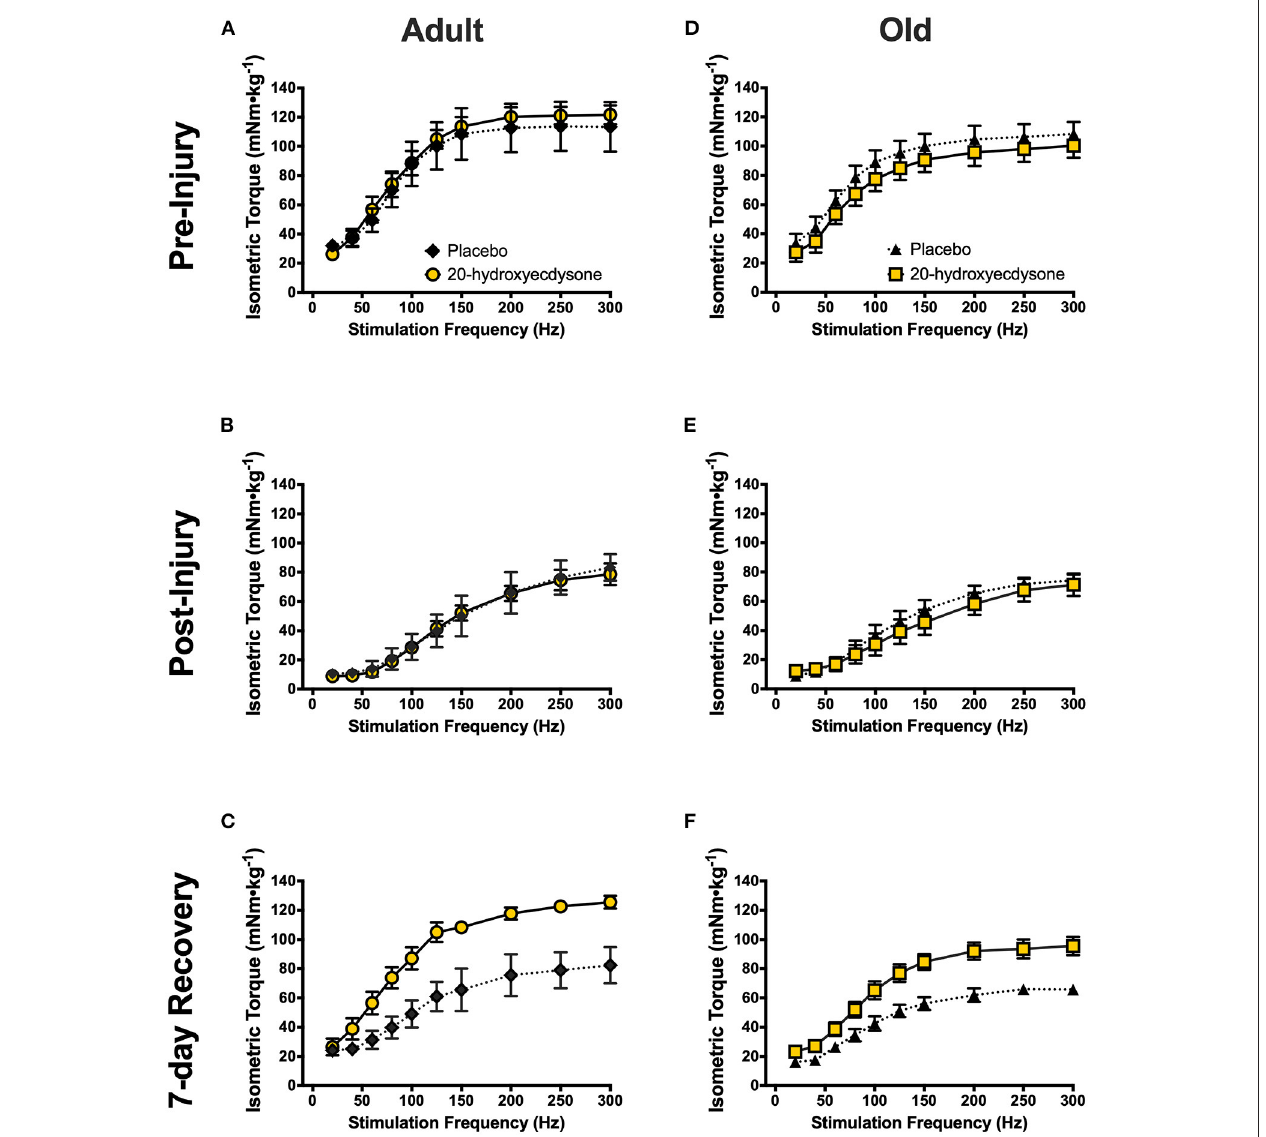
FIGURE 2 | Isometric torque-frequency relationships of the anterior crural muscles in adult and old mice at the pre-injury ( A,D , respectively), immediately post-injury ( B,E , respectively), and 7-day recovery ( C,F , respectively) time points. Analysis revealed significant reductions in isometric torque-frequency relationships in both adult (B) and old mice (E) immediately after the eccentric contraction-induced muscle damage protocol (Post-Injury), compared to Pre-Injury ( A,D , respectively; p < 0.001), regardless of treatment condition. Torque-frequency relationships fully recovered to Pre-Injury levels by the 7-day Recovery time point in both 20E-treated adult (C) and old mice (F) , but PLA-treated mice did not recover ( p = 0.005). Values represent mean ± SEM. PLA, placebo; 20E,